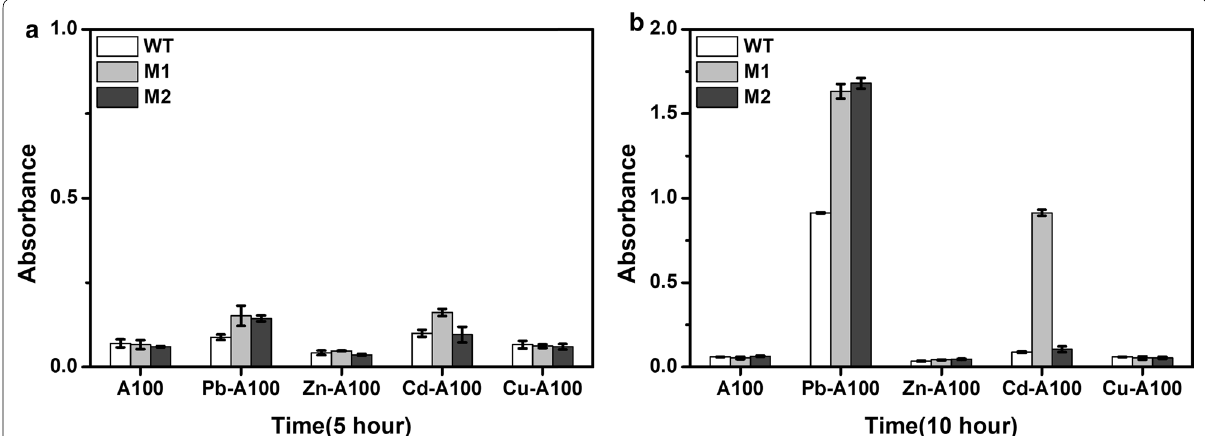
Fig. 7 Comparison of the growth of the mutants in response to lead, zinc, cadmium, and copper in presence of ampicillin for a 5 h and b 10 h. White bar: Wild type; Grey bar: Mutant M1; Black bar: Mutant M2. Metals were used at 50 µM. Ampicillin was used at 100 µg mL − 1 . Experiments were performed in triplicate, and data represent the averages and standard deviations of the means